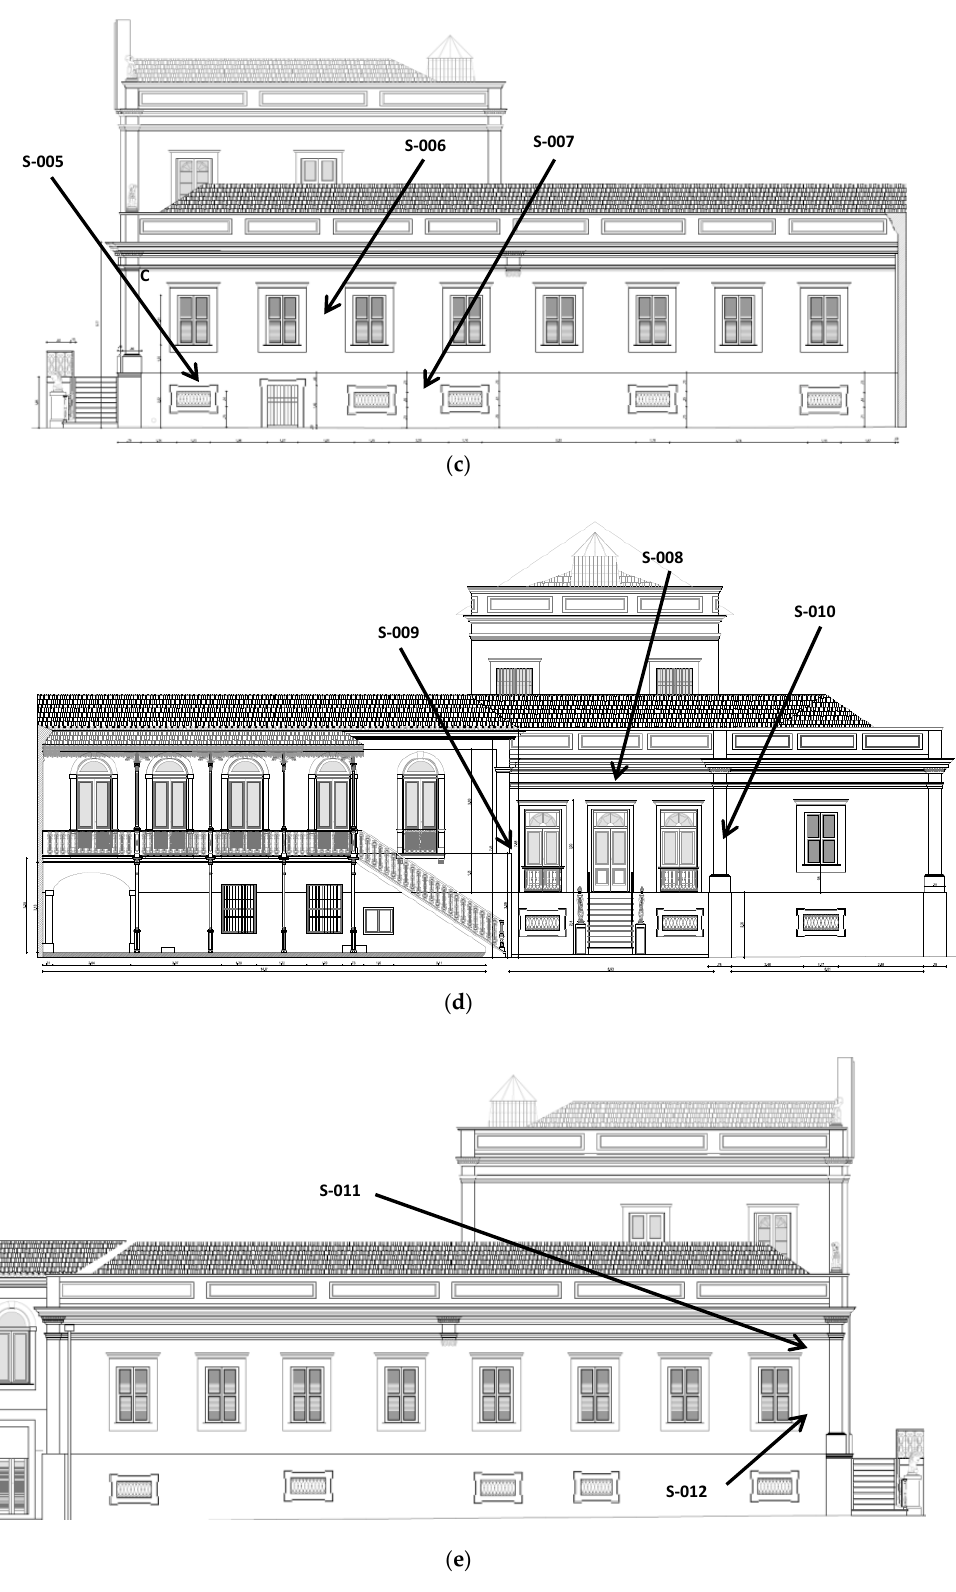
Figure 2. ( a ) Plant of Rui Barbosa House Museum; ( b ) South side, ( c ) East side, ( d ) North side, and ( e ) West